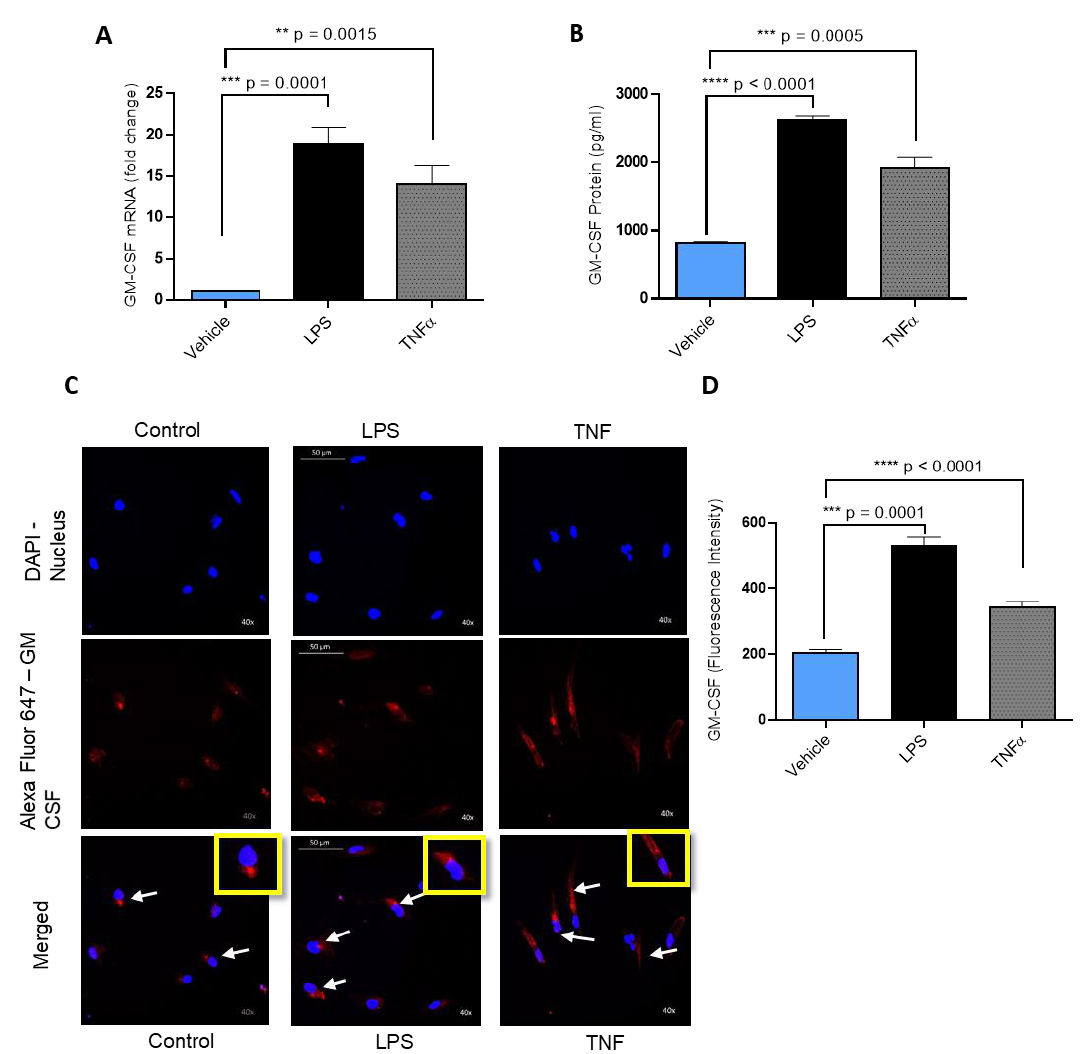
Figure 1. Effect of lipopolysaccharide (LPS) on granulocyte–macrophage colony-stimulating factor (GM-CSF) production in human MDA-MB-231 cells. MDA-MB-231 cells were cultured in six-well plates at a concentration of 1 × 10 6 cells/well. Cells were treated with vehicle, LPS (10 ng/mL), and TNF-α (10 ng/mL; positive control) separately. After 24 h incubation, cells and supernatants were collected. ( A ) Total cellular RNA was isolated, and GM-CSF mRNA expression was determined by real-time RT-PCR. ( B ) Secreted GM-CSF protein in culture media was determined by ELISA. ( C ) MDA-MB-231 cells were treated with vehicle, LPS, or TNF-α for 24 h and then were stained with GM-CSF (red) and 4′,6-diamidino-2-phenylindole (DAPI) (blue). White arrows indicate typical stained cells. ( D ) GM-CSF fluorescence intensity was determined for 10 random images. The results obtained from three independent experiments are shown. All data are expressed as mean ± SEM (n ≥ 3). ** p < 0.01, *** p < 0.001, **** p < 0.0001 versus vehicle.